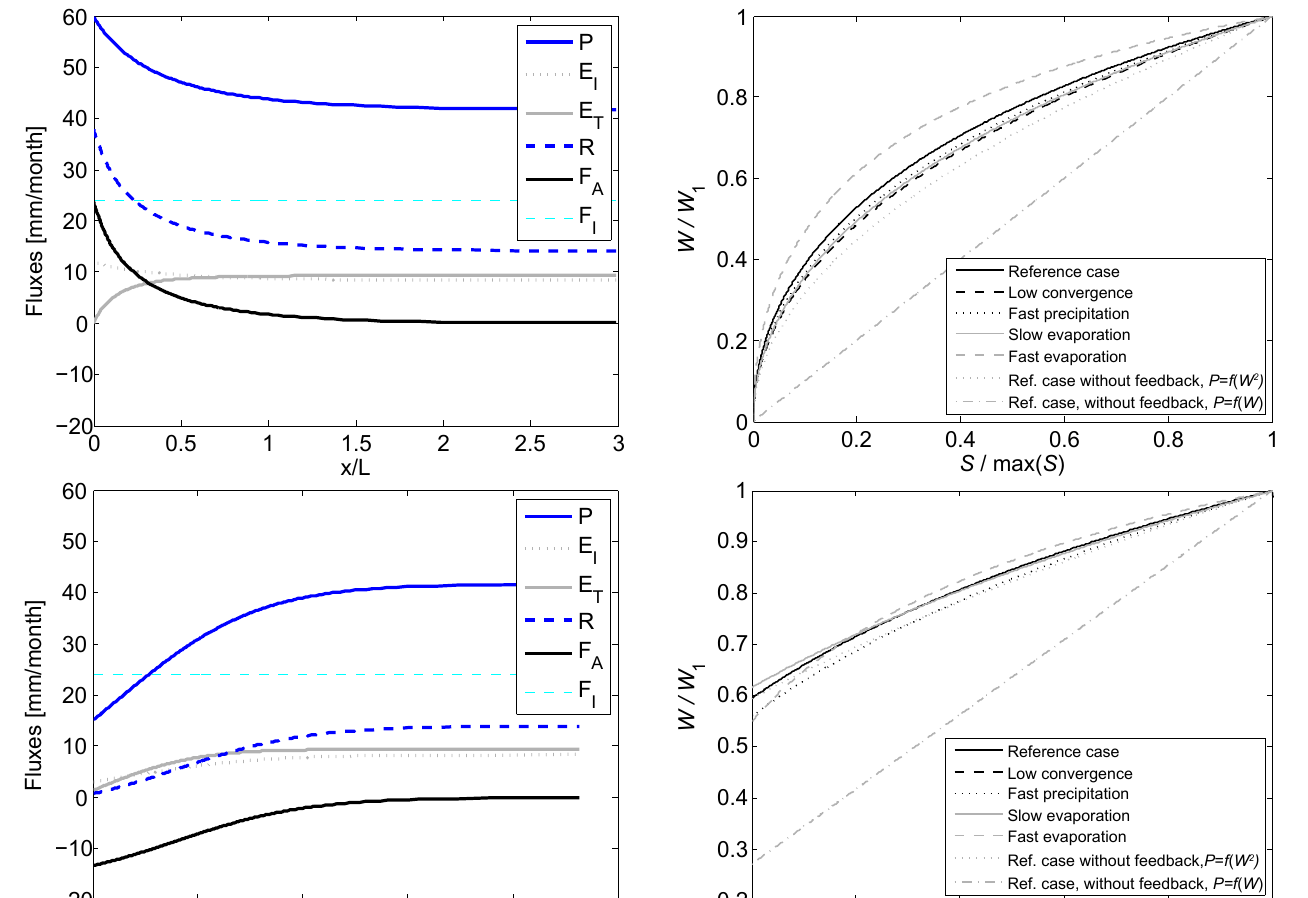
Fast precipitation Slow evaporation Fast evaporation Ref. case without feedback, P = f ( W 2 )